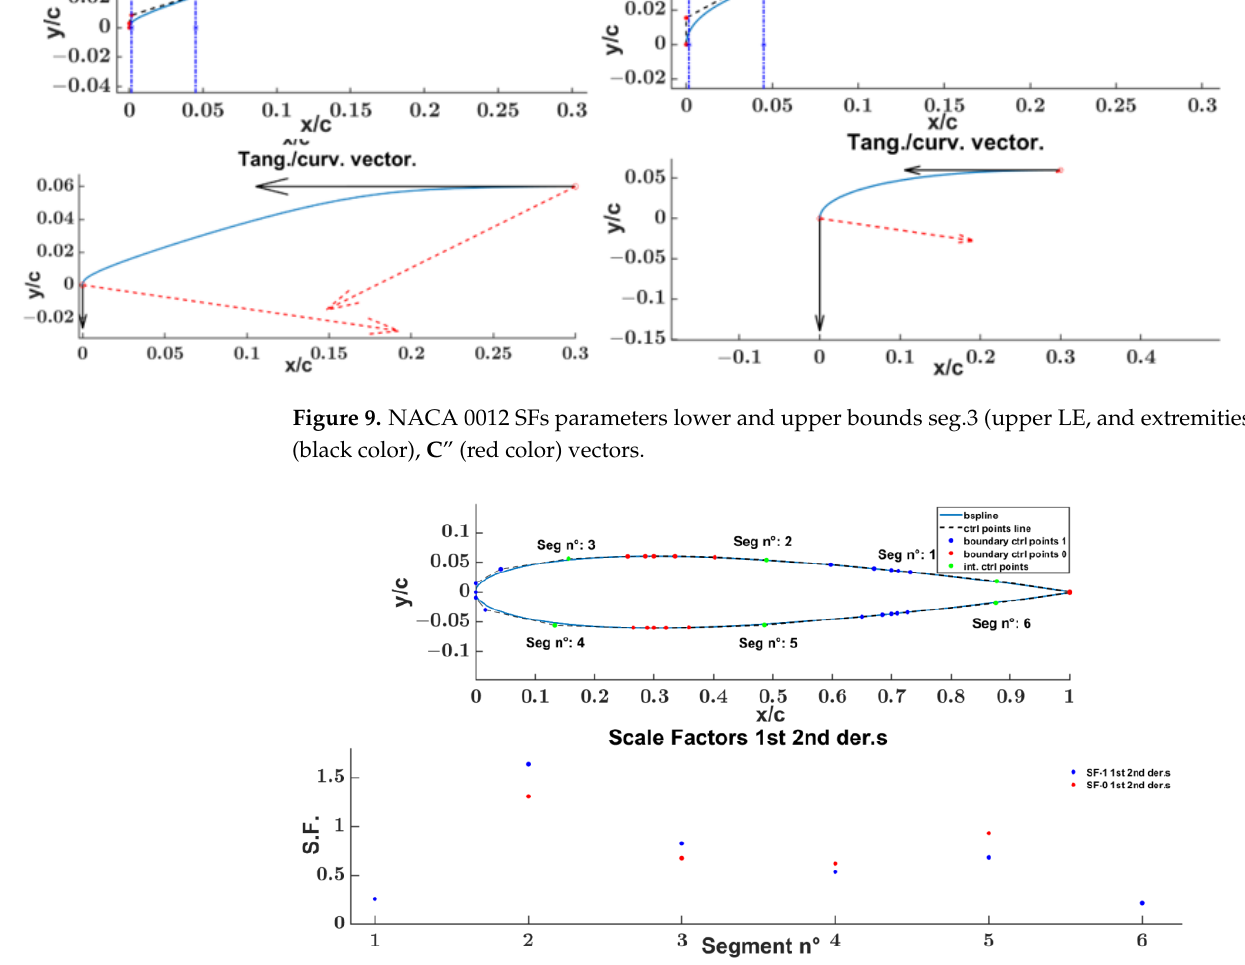
Figure 10. Central NACA 0012 example of SF parameters numbers and values. Table 6. Segment-wise evaluated SFs.